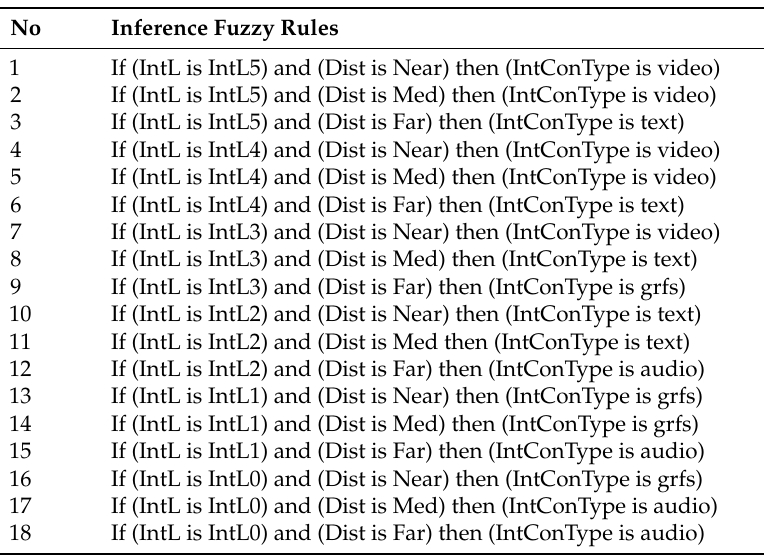
Table 1. Inference fuzzy rules of the FIS.